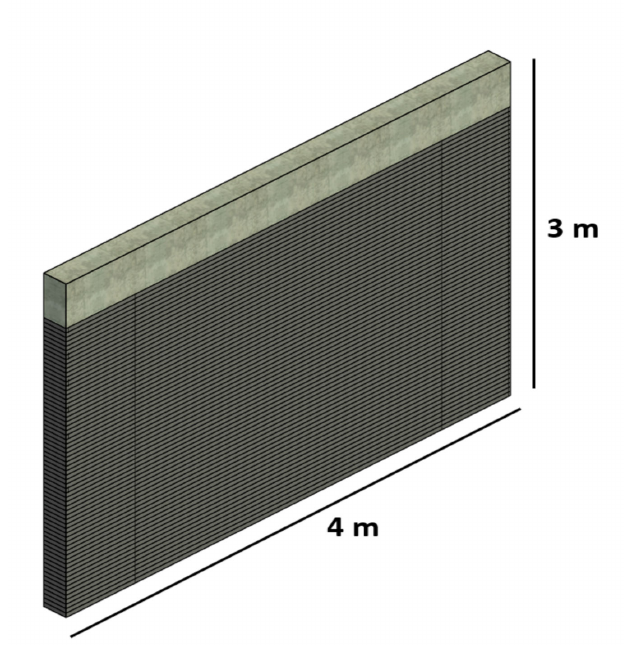
Figure 4. Graphic of 3DCP construction method with reinforced concrete structural system